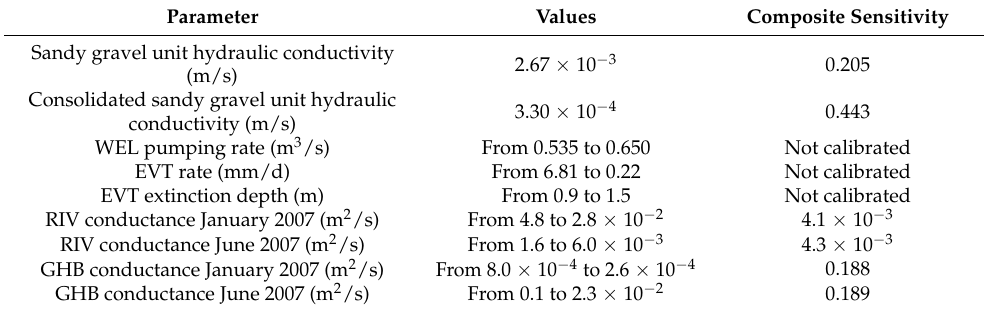
Table 2. Parameters used in the groundwater flow model and composite parameter